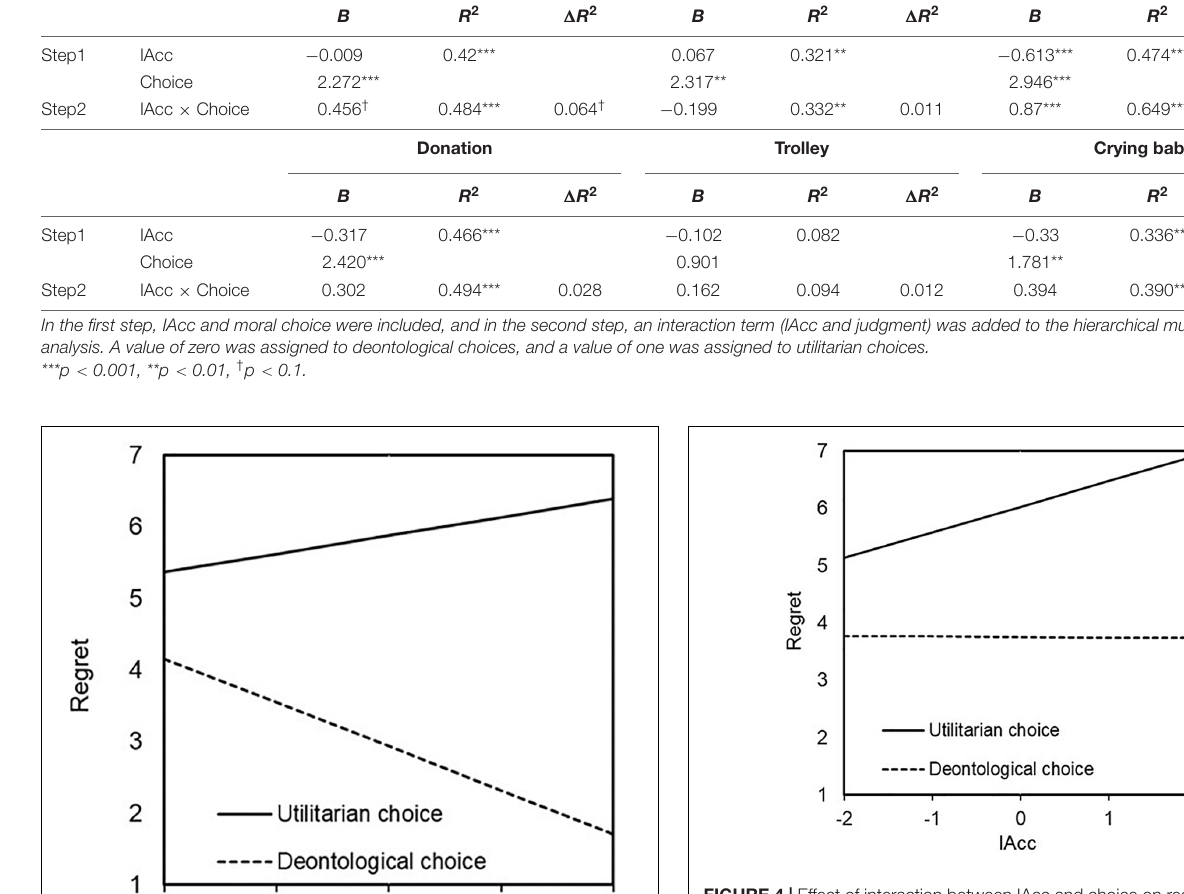
FIGURE 4 | Effect of interaction between IAcc and choice on regret in Bus plunge. The higher they rated interoceptive accuracy, the higher they rated regret when they made a utilitarian choice but not when they made a deontological choice (utilitarian B = 0.447, p < 0.01; deontology B = –0.009, n.s.